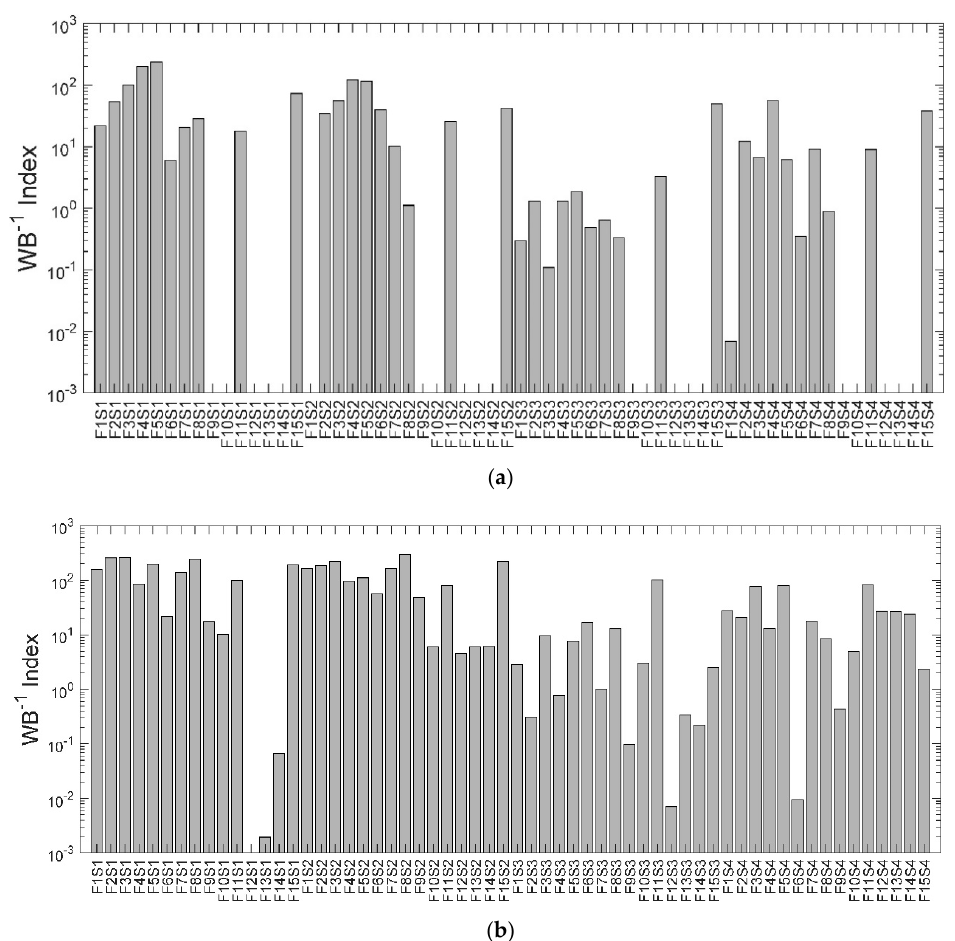
Figure 3. WB − 1 index values for each feature (F1 to F15), for each statistic (S1 to S4, respectively, mean, variance, skewness and kurtosis) and for terrain ( a ) and slippage ( b ) classifier.